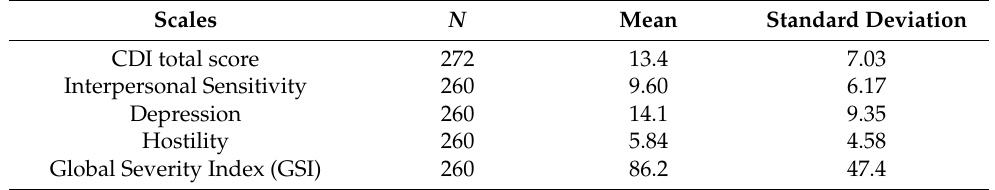
Table 1. Mean scores on the CDI; the interpersonal sensitivity, depression, and hostility scales; and the GSI of the